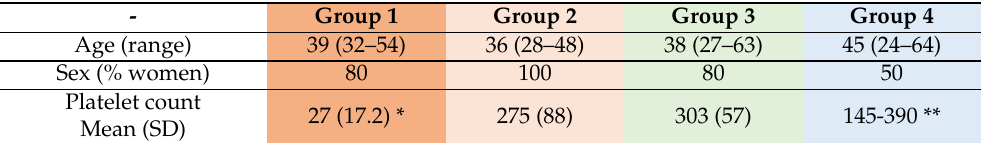
Group 1: patients with VITT. Group 2: patients with prolonged symptoms of headache and skin hemorrhages, Group 3: Individuals with brief or no symptoms, Group 4: healthy controls. Data for age and platelet counts (10 9 /L) are medians and ranges and mean ± SD, respectively. For One-way ANOVA comparison of age between groups; p = 0.200. For One-way ANOVA comparison of platelet counts between patient groups; p < 0.0001.